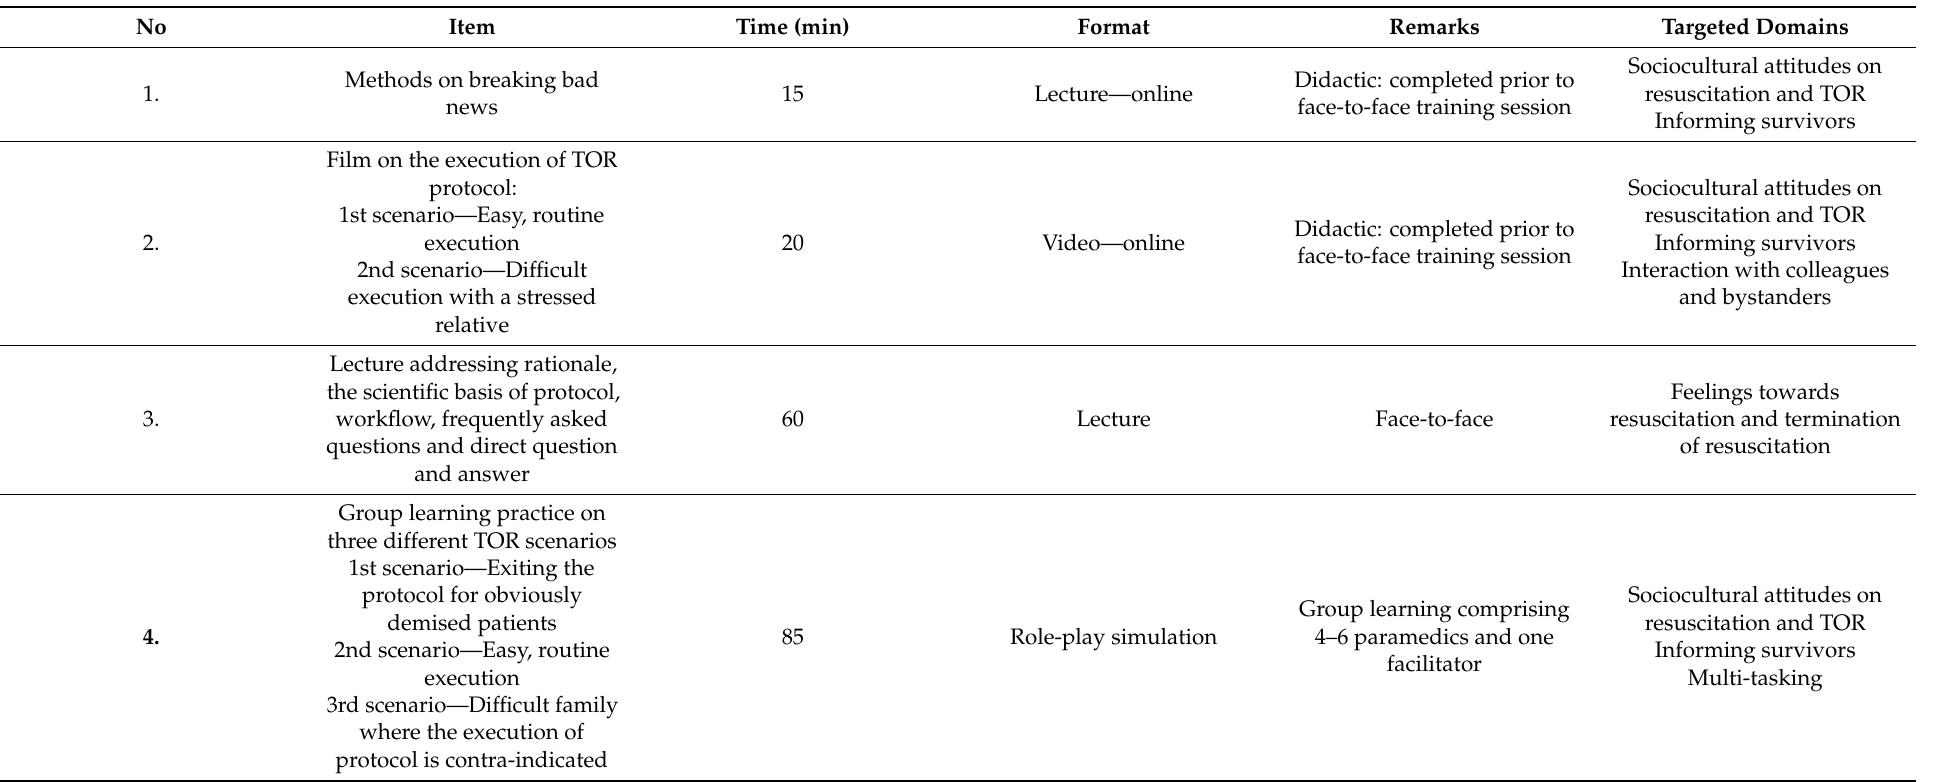
Table 1. Training with targeted